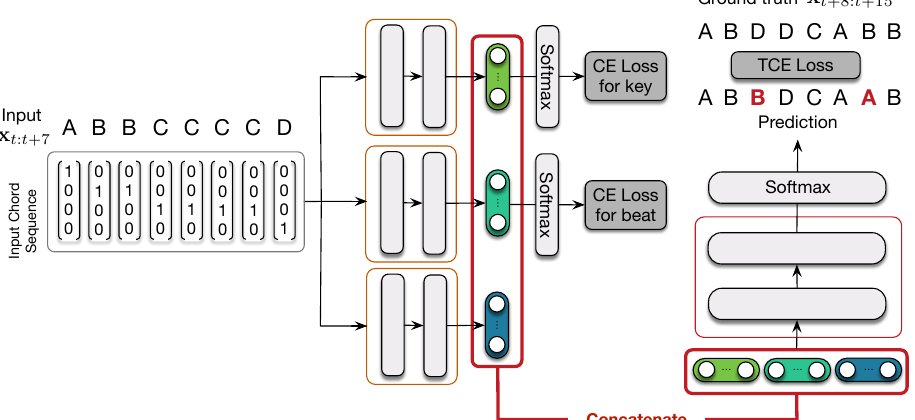
Figure 7. The architecture of our proposed models (MLP-Aug) that learns the key and the downbeat position in order to improve the chord sequence continuation.